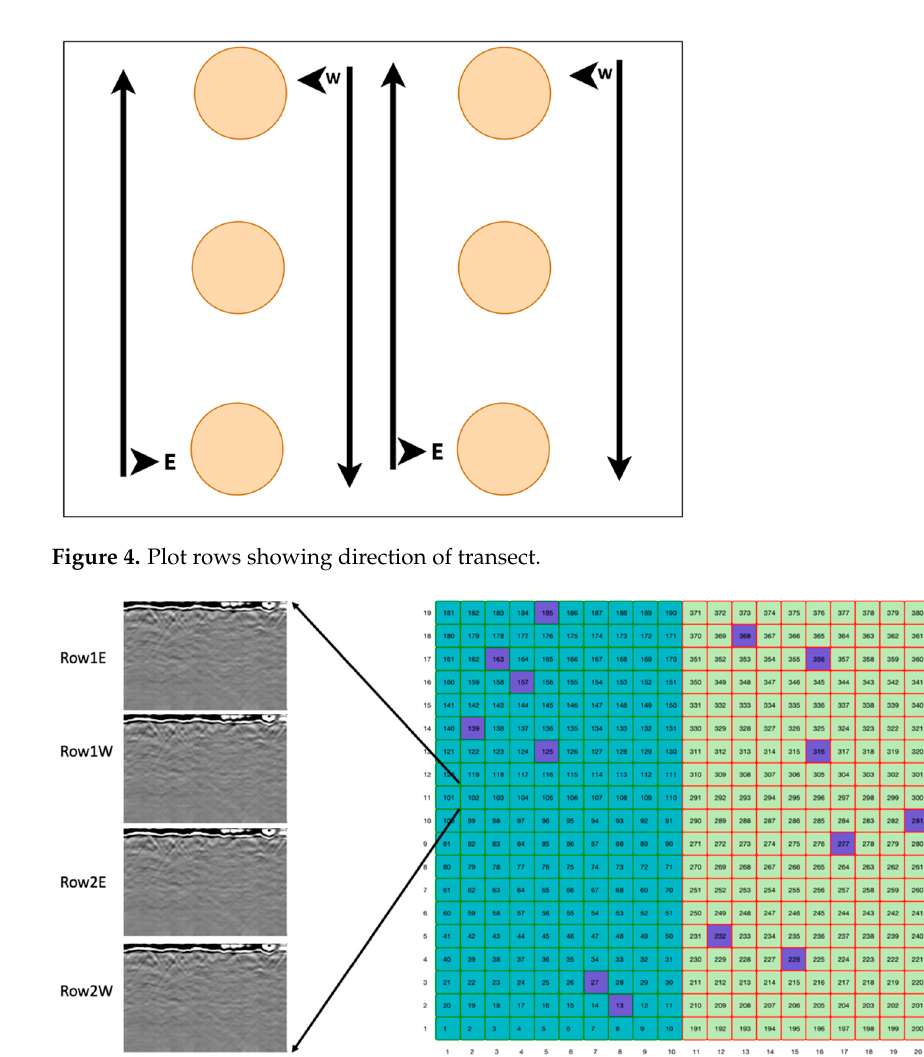
Figure 5. Sample fi eld plot representation using 8-bit gray-scale B-scan